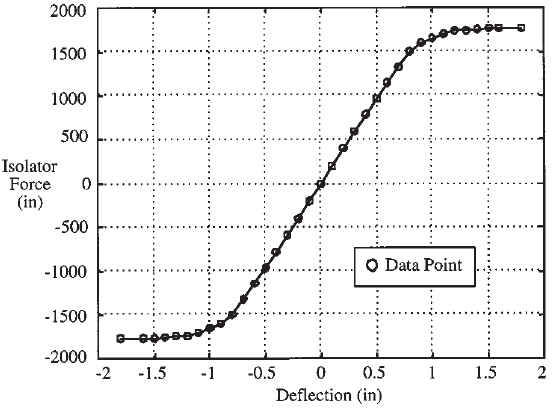
Fig. 4. Nonlinear isolator stiffness force-deflection